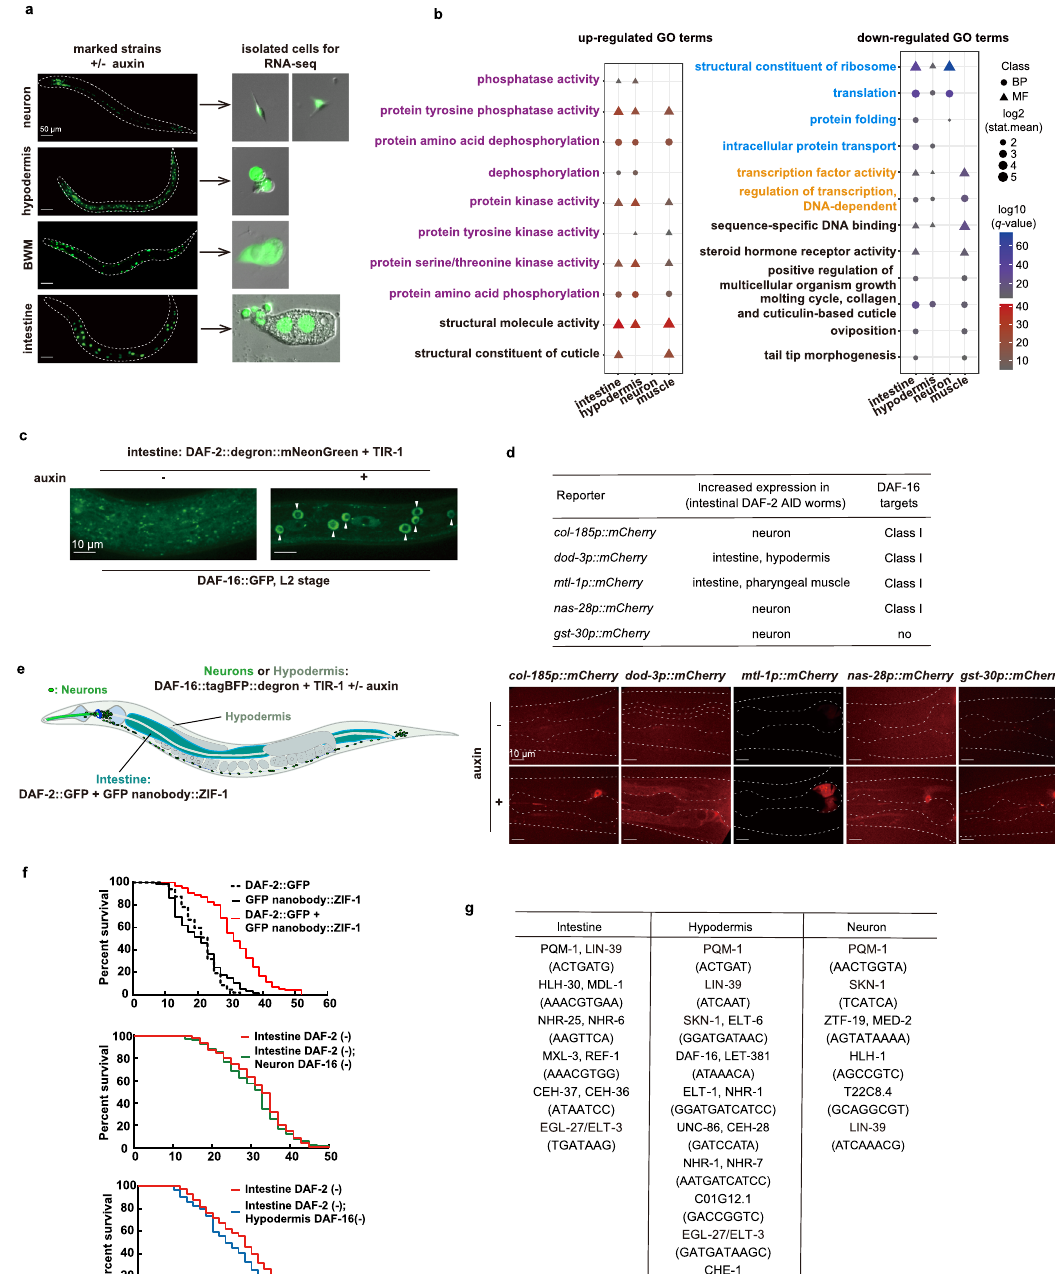
Fig. 7 | Loss of intestinal DAF-2 triggered gene expression changes in other tissues through cross-tissue DAF-2 to DAF-16 signaling. a Isolation of neurons, hypodermis,bodywallmuscle(BWM),andintestinecellsfromintestinalDAF-2AID wormsforRNA-seq.Leftpanel,tissue-speci fi ctransgenicreportersinthe intestinal DAF-2 AID strain used to isolate tissue-speci fi c cells. Neurons, labeled by rgef- 1p::NuGFP ; hypodermis, labeled by dpy-7p::NLS SV40 ::GFP ; BWM, labeled by myo- 3p::NuGFP ; intestine, labeled by ges-1p:: NuGFP . Right panel, representative images oftissue-speci fi ccellsisolatedbyFACSforRNA-seq.Asimilarpatternofexpression was observed in two independent experiments. b GSEA analysis of up-regulated and down-regulated GO terms enriched in each isolated tissue. GO terms with q - value<0.01 in at least two tissues are shown. For multiple comparisons, adjust- mentsweremadewithBenjamini – Hochberg(BH)method. c DegradingDAF-2from the intestine induces DAF-16 nuclear accumulation in the hypodermis at the L2 larval stage. A similar pattern of expression was observed in three independent experiments. d Five DEGs selected to verify the cross-tissue effect of intestinal IIS on non-intestinal tissues by mCherry transgenic reporters in the intestinal DAF-2